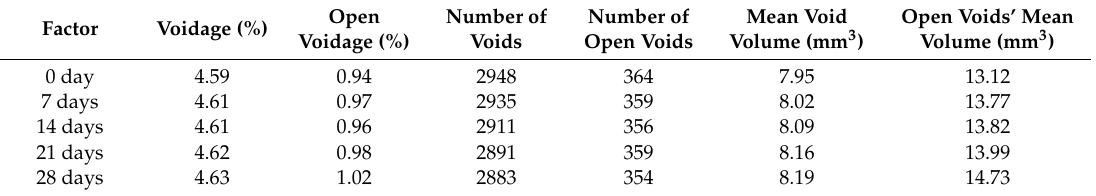
Table 10. Void Calculation Data for the AC1 Specimen (Under Water Soaking Conditions).